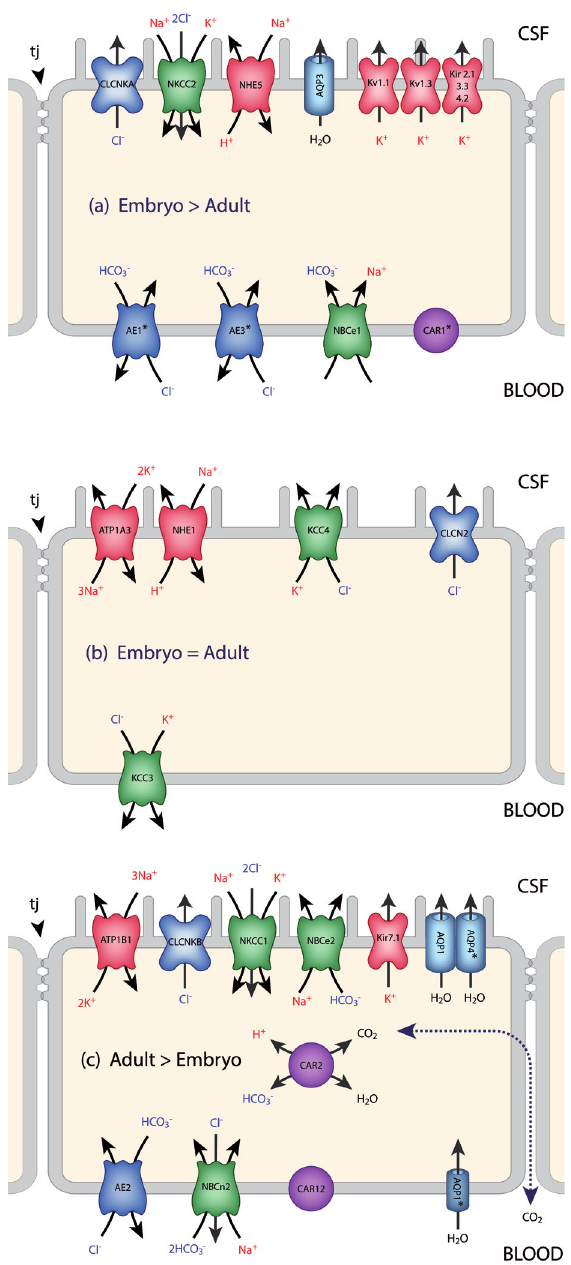
Figure 2. Transporters and ion channels in choroid plexus epithelial cells. Data for the localization of transporters and ion channels are from Damkier et al. 25 and Brown et al. 96 . CSF secretion results from coordinated transport of ions and water from basolateral membrane to cytoplasm, then sequentially across apical membrane into ventricles 25 . The genes for many of these transporters and ion channels are differentially expressed in the embryo compared to the adult. This is represented in the three panels. It is emphasized that this represents differential expression, not the absence of a gene at one age (details are in 35). On the plasma-facing membrane is parallel Cl - /HCO 3- exchange (AE2 [ Slc4a2 ] > in adult and AEI [ Slc4a1 ], AE3 [ Slc4a3 ] > in embryo) and Na + /HCO 3- co-transport (NBC1 [ Slc4a4 ] > in embryo) with net function bringing Cl - into cells in exchange for HCO 3-97 . Also basolaterally located is an Na-dependent Cl - /HCO 3- exchange (NCBE [ Slc4a10 ] > in adult) that modulates pH and perhaps CSF formation 98 . Apical Na + efflux by NHE5 ( Slc9a5 > in embryo) and ATB1 ( Atb1b 1 [Na + /K + -ATPase] > in adult) maintains a low cell Na + that sets up a favorable basolateral gradient to drive Na + uptake 99 . Na + is extruded into CSF mainly via the Na + /K + -ATPase pump (ATB1 [ Atb1b1 ]) and, under some conditions, the Na + /K + -Cl - co-transporter NKCC1, Slc12a2 (see 100 for review). Aquaporin (AQP1/3/4) channels on CSF-facing membrane mediate water flux into ventricles 101 . Polarized distribution of carbonic anhydrase (CAR) and Na + /K + -ATPases, and aquaporins, enable net ion and water translocation to CSF (see 100 and 102 for reviews). CLCKA (CLCK1) is an inwardly rectifying chloride channel; its gene ( Clcnka ) in embryonic choroid plexus is expressed many orders of magnitude higher than in the adult. Clcnkb is expressed at a higher level in the adult. CAR2 has an intracellular distribution and is functionally important for catalyzing - , which is an important part of the mechanism secreting CSF. There are many more channels that the equilibrium that generates H + and HCO 3 show age-related differential expression in choroid plexus, the functions of which are unclear 26 . Page 6